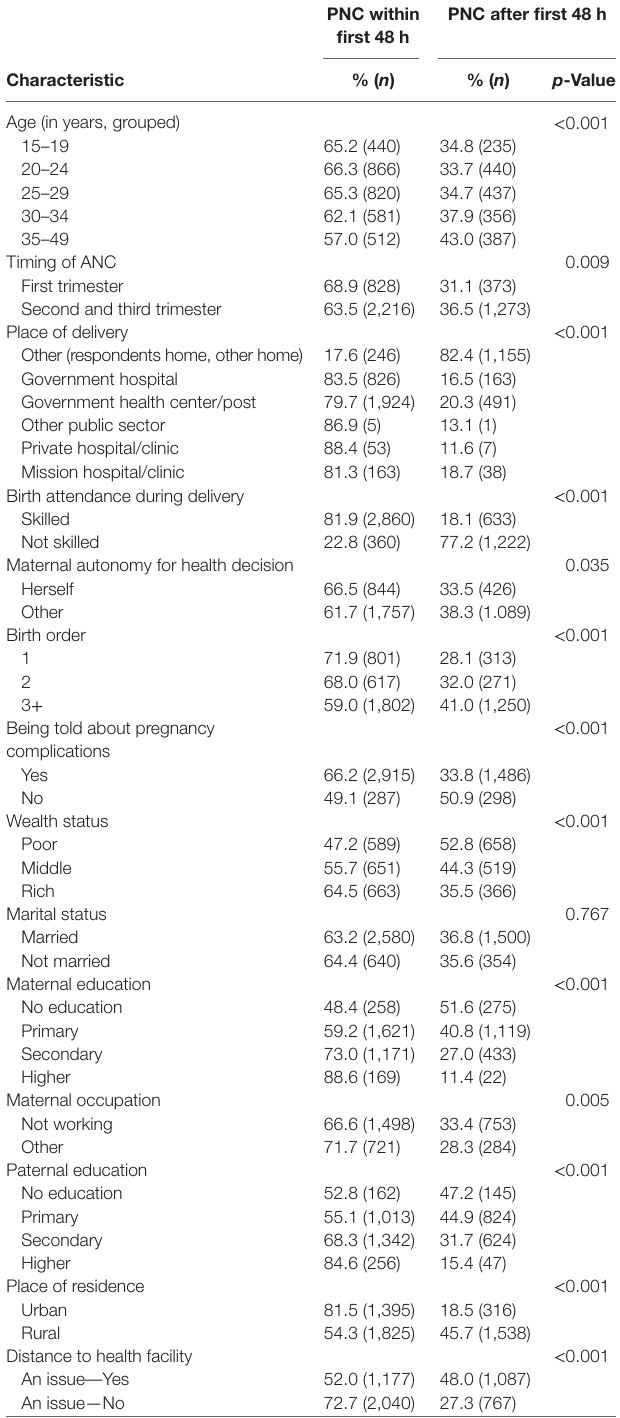
Pnc within Pnc after first 48 h first 48 h